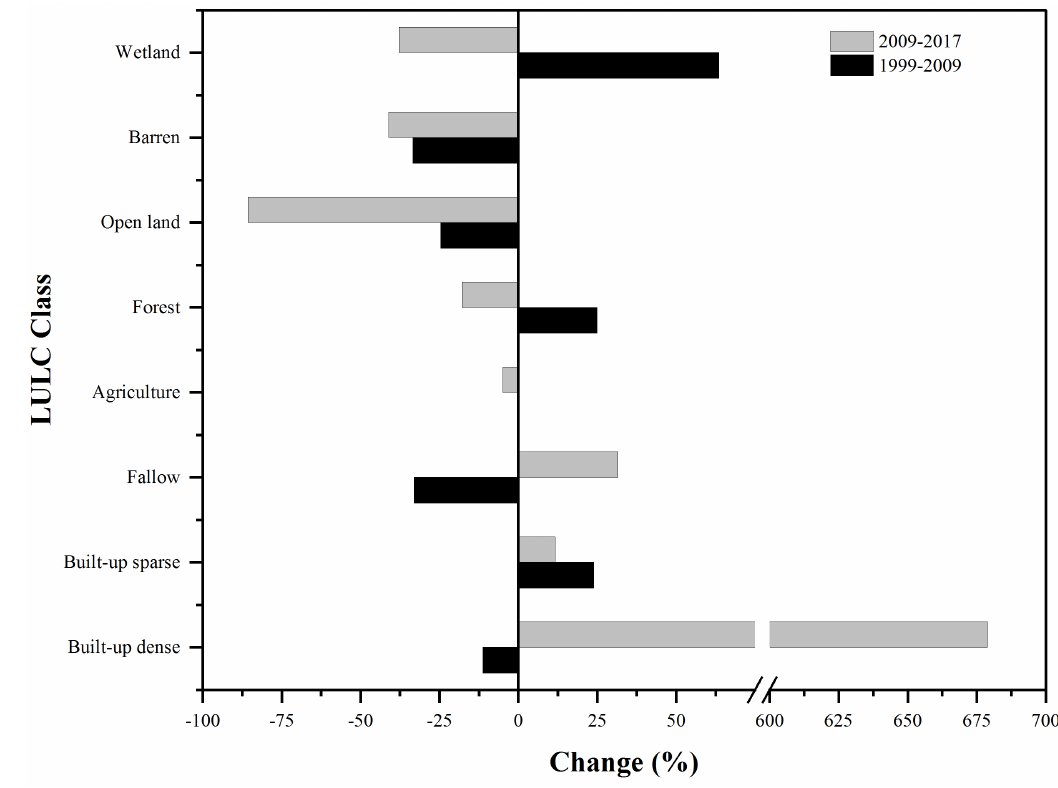
Figure 4. LULC changes in di ff erent classes for the outer zone (OZ) in T 1 and T 2 .